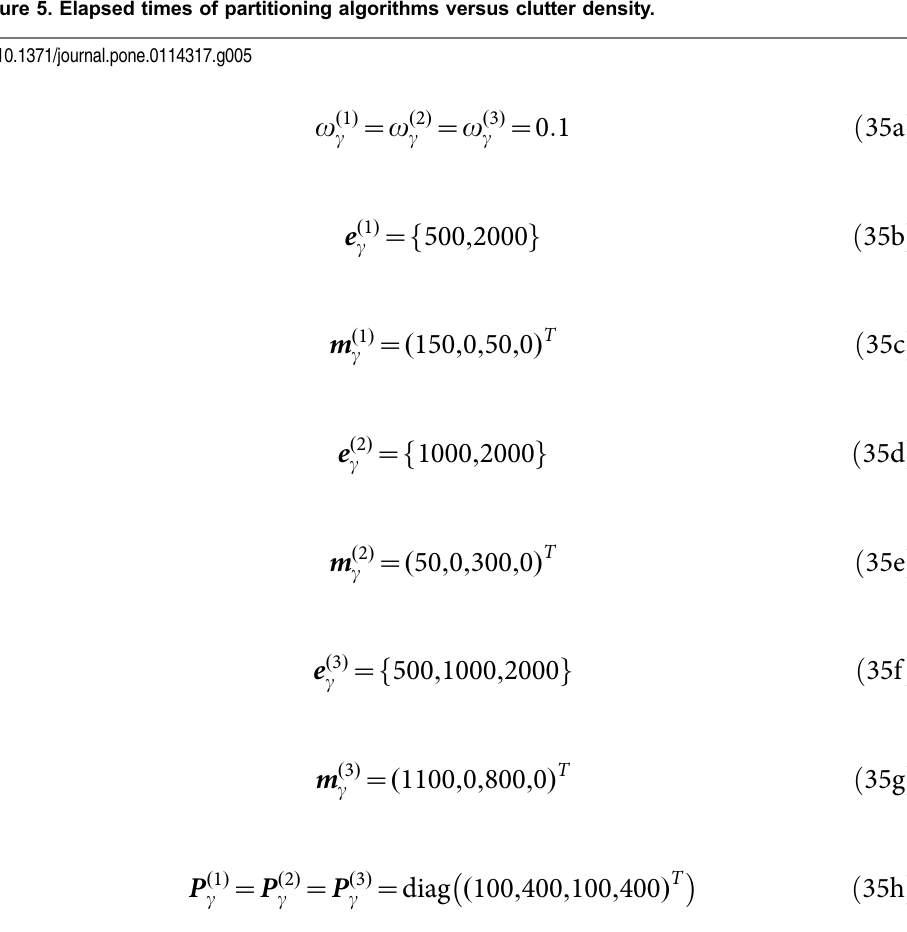
Figure 5. Elapsed times of partitioning algorithms versus clutter